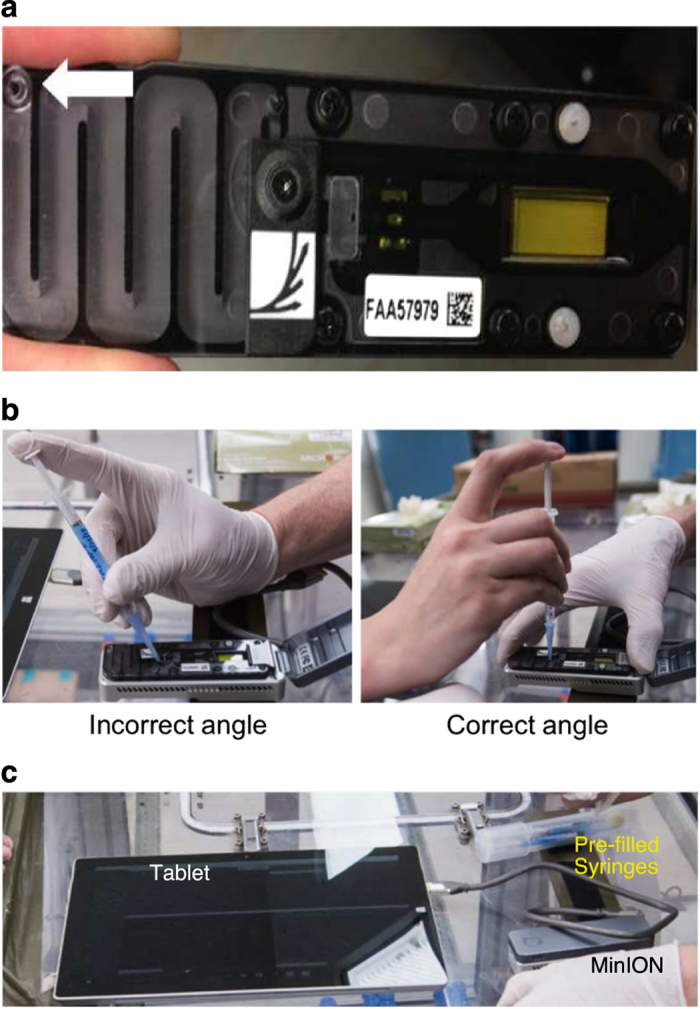
(a) The MinION flow cell, which was loaded into the device prior to the parabolic flight. The white arrow marks vents, which leaked during return transport to the Johnson Space Center. (b) Loading the library onto the MinION. Angling the pipette perpendicularly to the pore was necessary to avoid introducing air bubbles. (c) The MinION setup on the plane. The flow cell was connected to a tablet running Oxford Nanopore Technologies' MinKNOW sequencing software via a USB 3.0 cable. We noted significant glare off of the tablet screen.